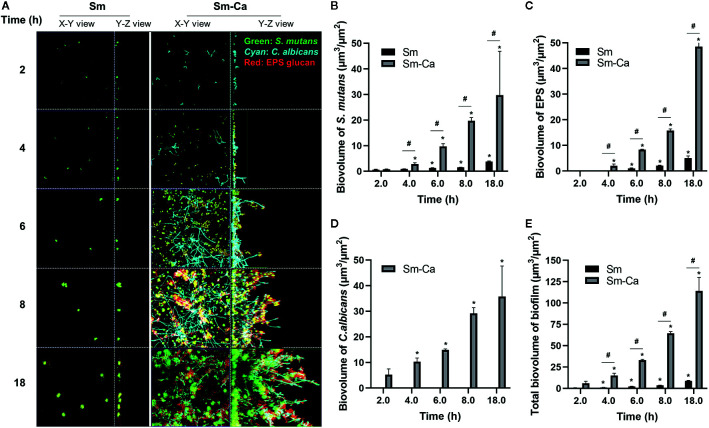
Confocal images of biofilms and quantification of biofilm components. (A) Representative top (X–Y) and orthogonal (Y–Z) views of confocal images of Sm and Sm-Ca biofilms at 2, 4, 6, 8, and 18 h cultured under SAL100. Bacterial cells are labeled with SYTO 9 (green), fungal cells with concanavalin A-tetramethylrhodamine (Cyan), and EPS α-glucan with Alexa Fluor 647 (red). Quantified biovolume of (B)
S. mutans, (C) EPS, (D)
C. albicans, and (E) total (sum of S. mutans, C. albicans, and EPS) in the biofilm. Asterisk indicates that the p-values are significantly different from the biovolume of 2 h (ANOVA with Dunnett; *P < 0.05). Hash indicates that the p-values are significantly different between two groups (t-test #
P < 0.05).